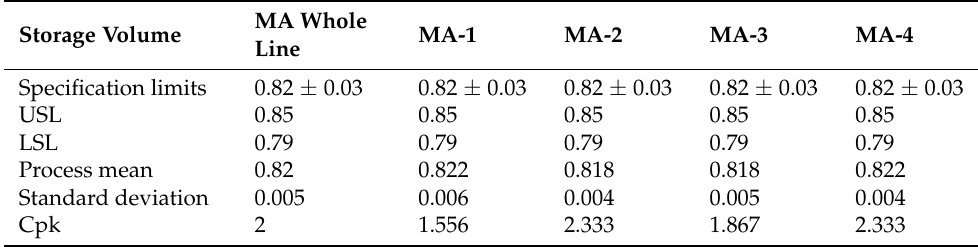
Table 4. Improved